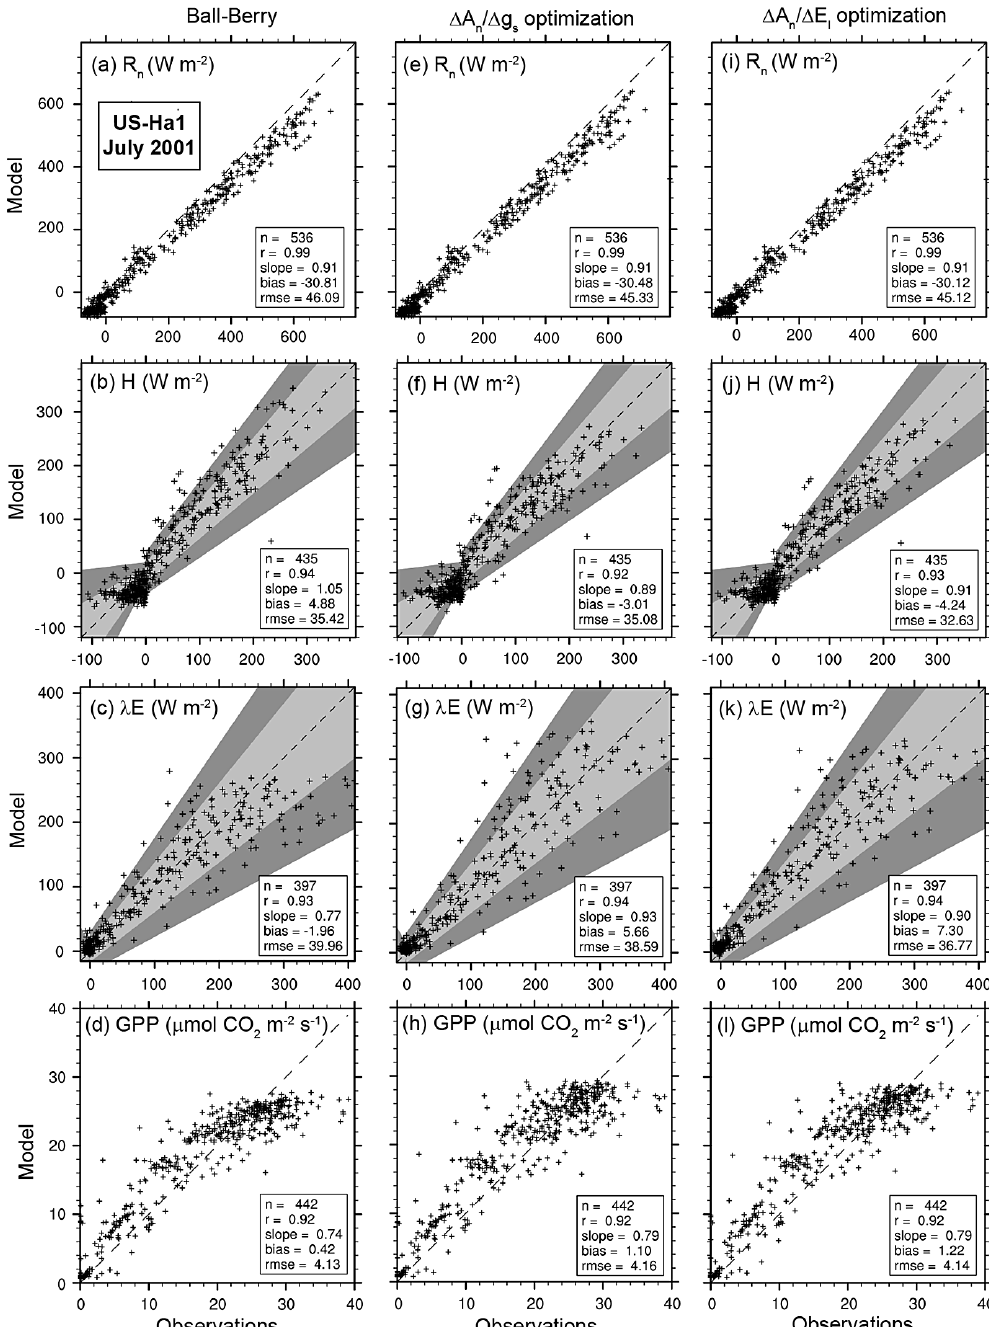
Figure 7. Canopy flux simulations for US-Ha1, July 2001. Shown are observed (horizontal axis) and simulated (vertical axis) net radiation ( R n ), sensible heat flux ( H ), latent heat flux ( λE ), and gross primary production (GPP) for the multi-layer canopy model with the CLM Ball–Berry model (left-hand panels; a – d ), SPA-iWUE optimization (middle panels; e – h ), and SPA-WUE optimization (right-hand panels, i – l ). The dashed line shows the 1 : 1 relationship, with the light and dark shading denoting ± 1 and ± 2 standard deviations, respectively, of the random flux error, σ(ε) . Statistics show sample size ( n ), correlation coefficient ( r ), slope of the regression line, mean bias, and root mean square error (RMSE). Data are shown for periods without rain. GPP is for daylight hours